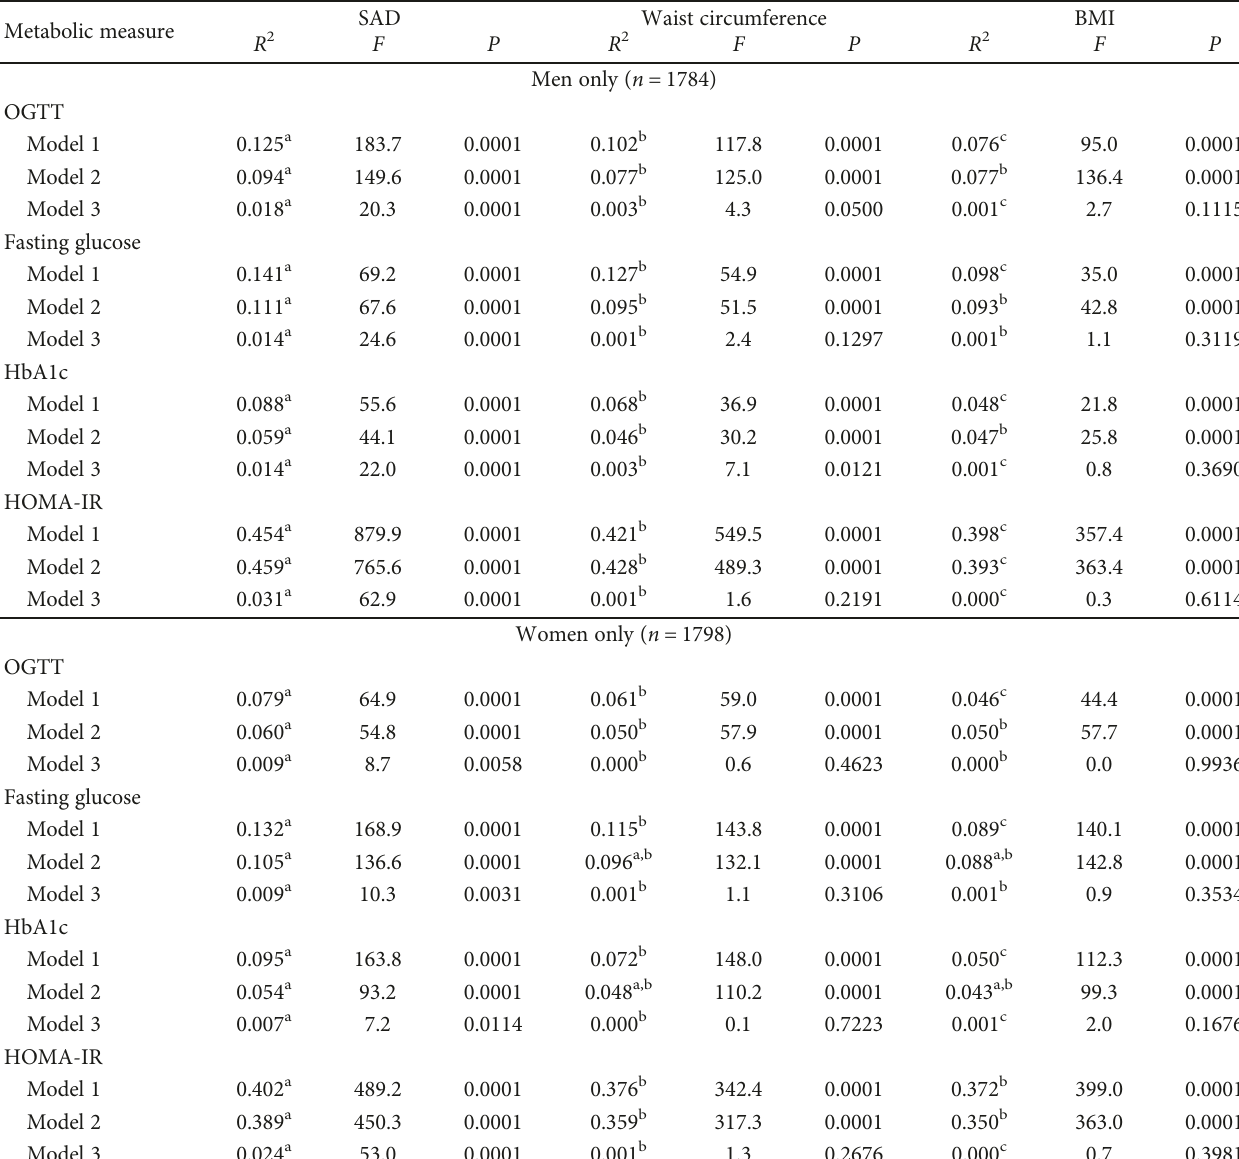
Table 3: Shared variance between the anthropometric variables and the glucose metabolism variables by gender. SAD Waist Metabolic measure